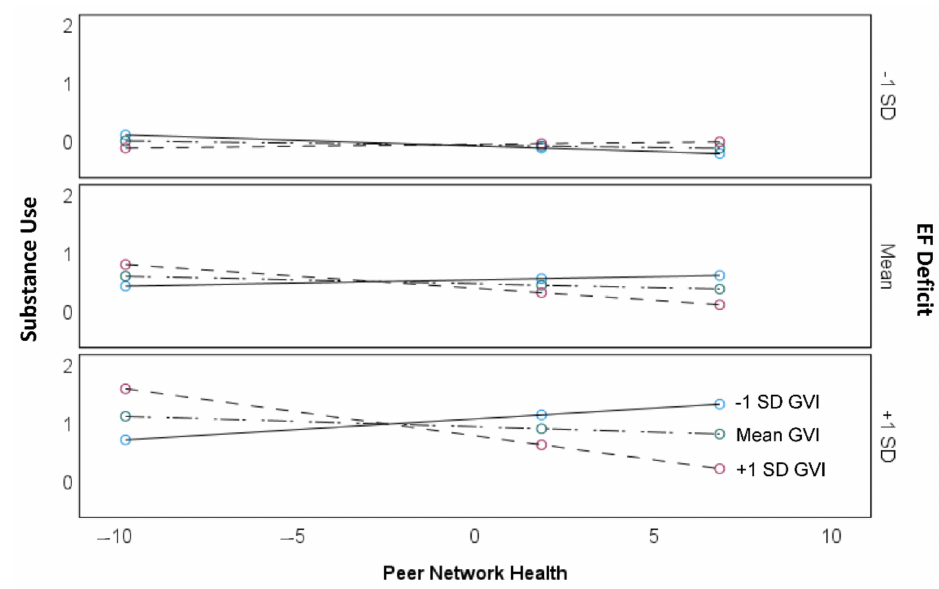
Figure 4. The moderating effect of GVI on the association of peer network health with substance use at different levels of executive functioning (EF). The bottom panel shows that for adolescents with a high level of EF deficit, GVI significantly moderates the association of peer network health with substance use, where at higher levels of GVI (short dashed line with red markers) the association is significant and negative. Whereas, when EF deficit is high, the peer network health-substance use association is not significant at mean (long dashed line with green markers) and lower levels (solid line with blue markers) of GVI. For adolescents with low EF deficit (top panel), there is no significant moderating effect of GVI on the association of peer network health with substance